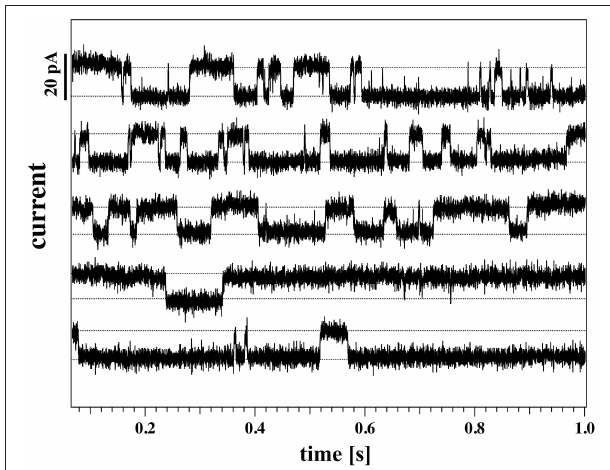
FIGURE 9 | Continuous current recording for the same membrane as Figure 8 (membrane 2) at a holding voltage of 190 mV, 4 mm below the water surface ( T = 297.15 K). The graph shows 5 consecutive seconds of recording, starting from the top row. The time-intervals are presented as a stack for clarity.